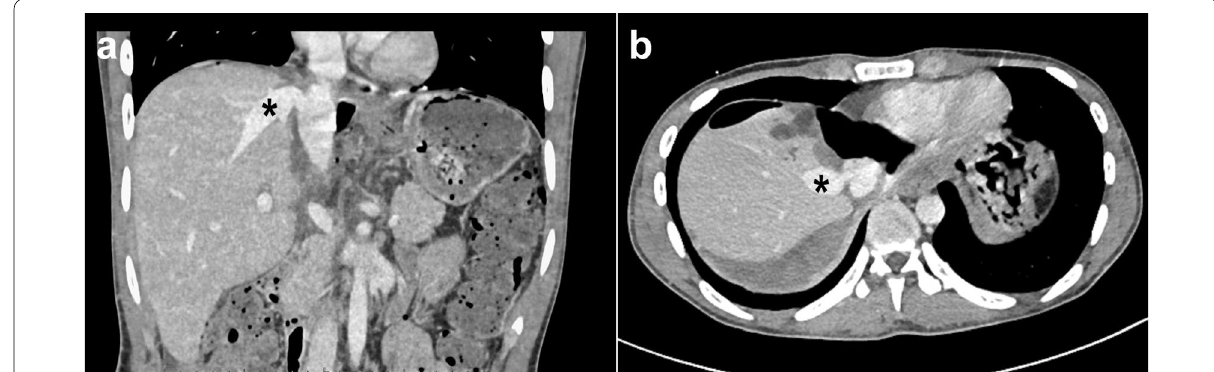
Fig. 5 Postoperative enhanced computed tomography showing the right hepatic vein graft (asterisk) and no stenosis in the inferior vena cava ( a coronal section, b axial